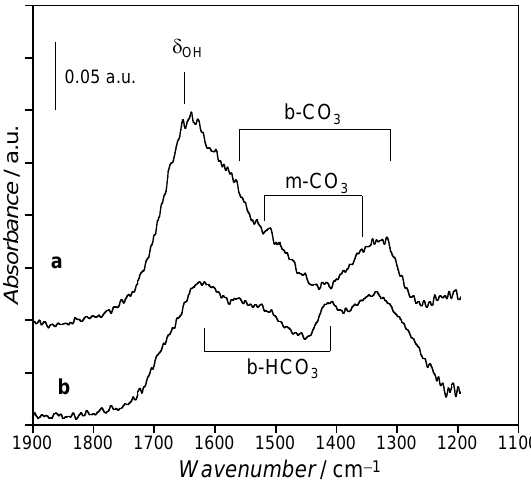
Figure 15. FTIR spectra of surface species recorded in air at 298 K. ( a ) Z m support; ( b ) 4.8NiO/Z hy catalyst precursor.